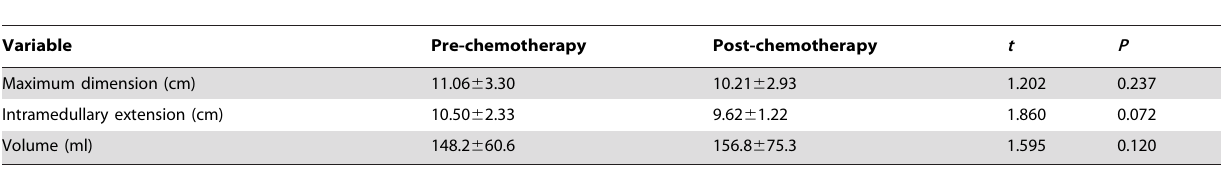
Table 1. Tumor size and volume at pre- and post-chemotherapy.